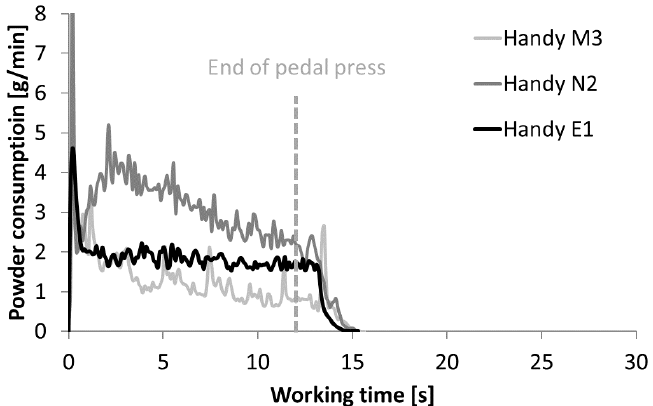
Figure 5. Handy powder consumption during one pedal press of 12 s.